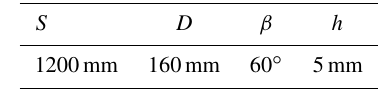
Figure 2. Schematic diagram of the simulation model